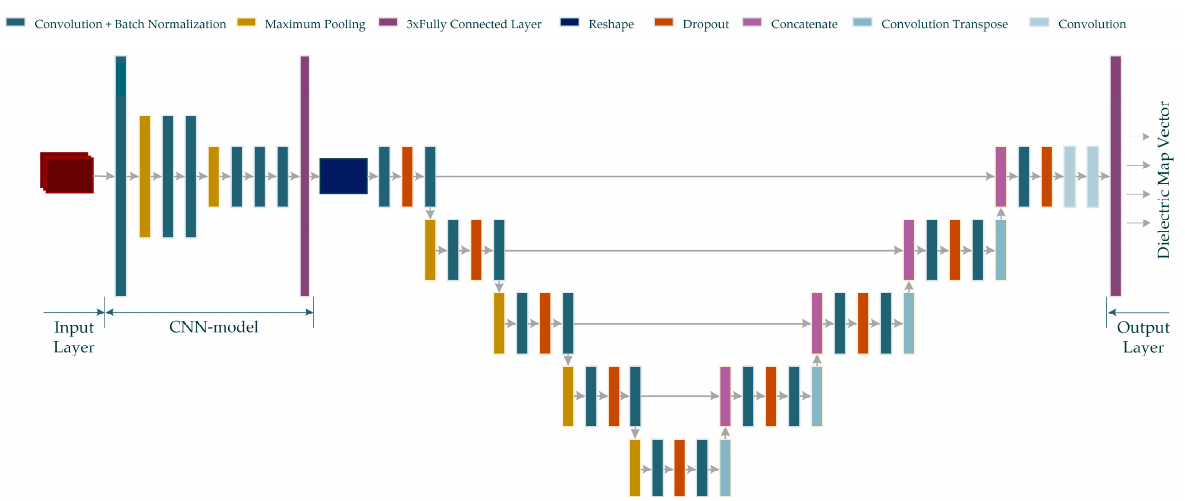
Figure 6. The proposed MWINet model for microwave medical imaging (Input data is shown in red color).